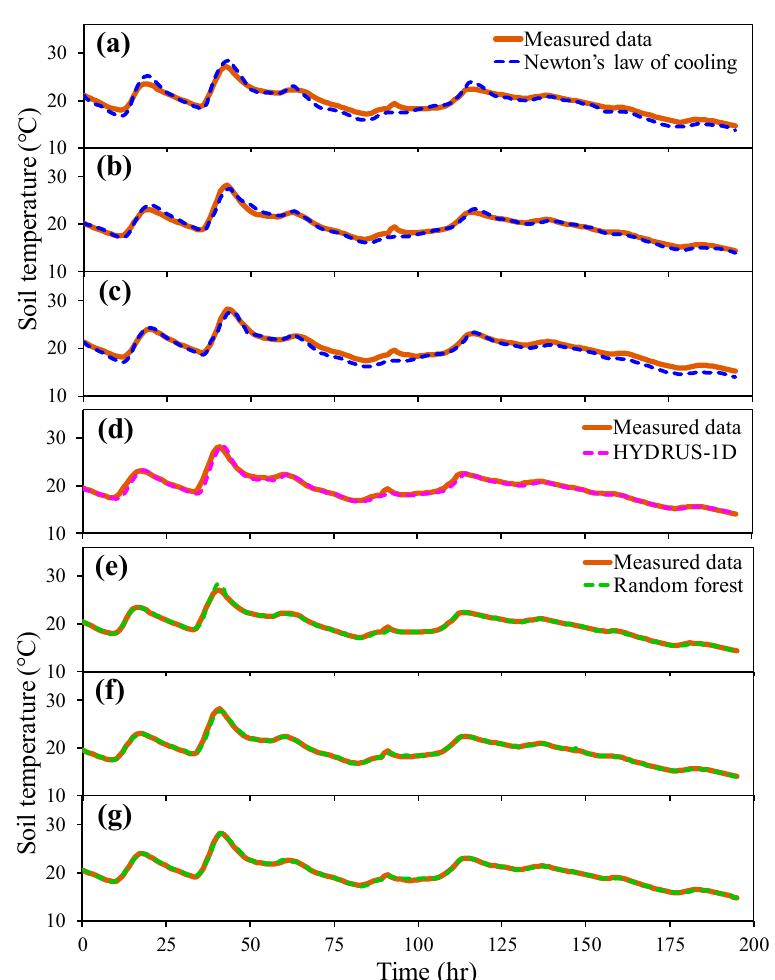
Figure 4. Soil temperature simulation of Newton’s law of cooling for baskets ( a ) No. 12 k = − 0.306 h − 1 , ( b ) No. 13 k = − 0.214 h − 1 , and ( c ) No. 14 k = − 0.221 h − 1 . Soil temperature simulation by HYDRUS-1D with the measured / empirical parameters in basket ( d ) No. 13. Soil temperature simulation of the random forest model for baskets ( e ) No. 12, ( f ) No. 13, and ( g ) No. 14. The orange lines are the test set of the measured soil temperature.